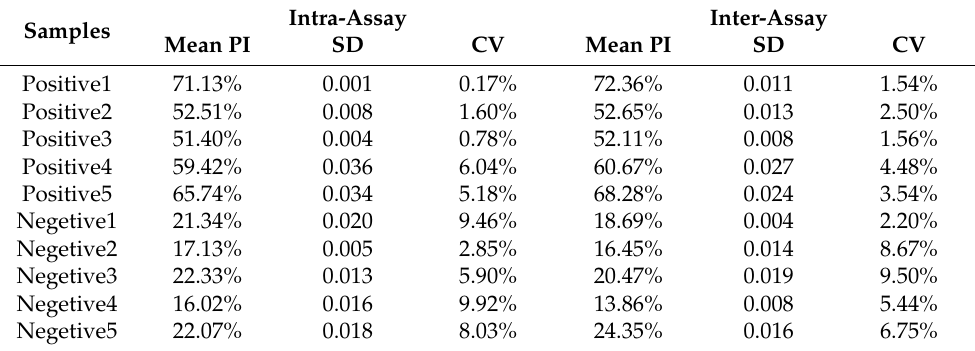
Table 3. Intra- and inter-assay repeatability of the 6A5/6F9-based blocking ELISA.